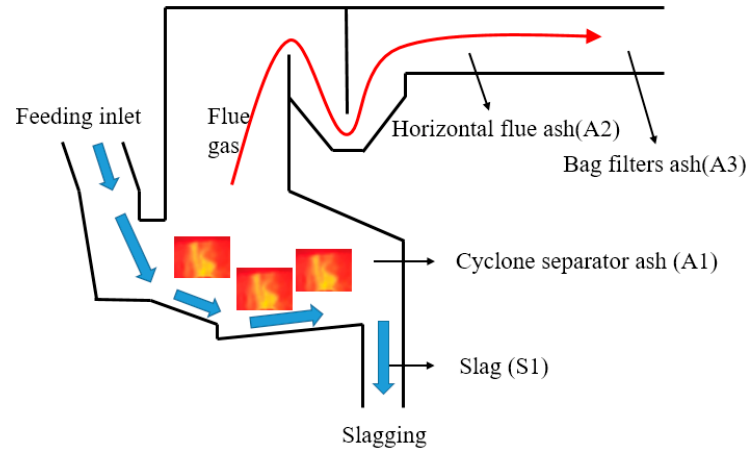
Figure 6. Schematic diagram of the sampling location.